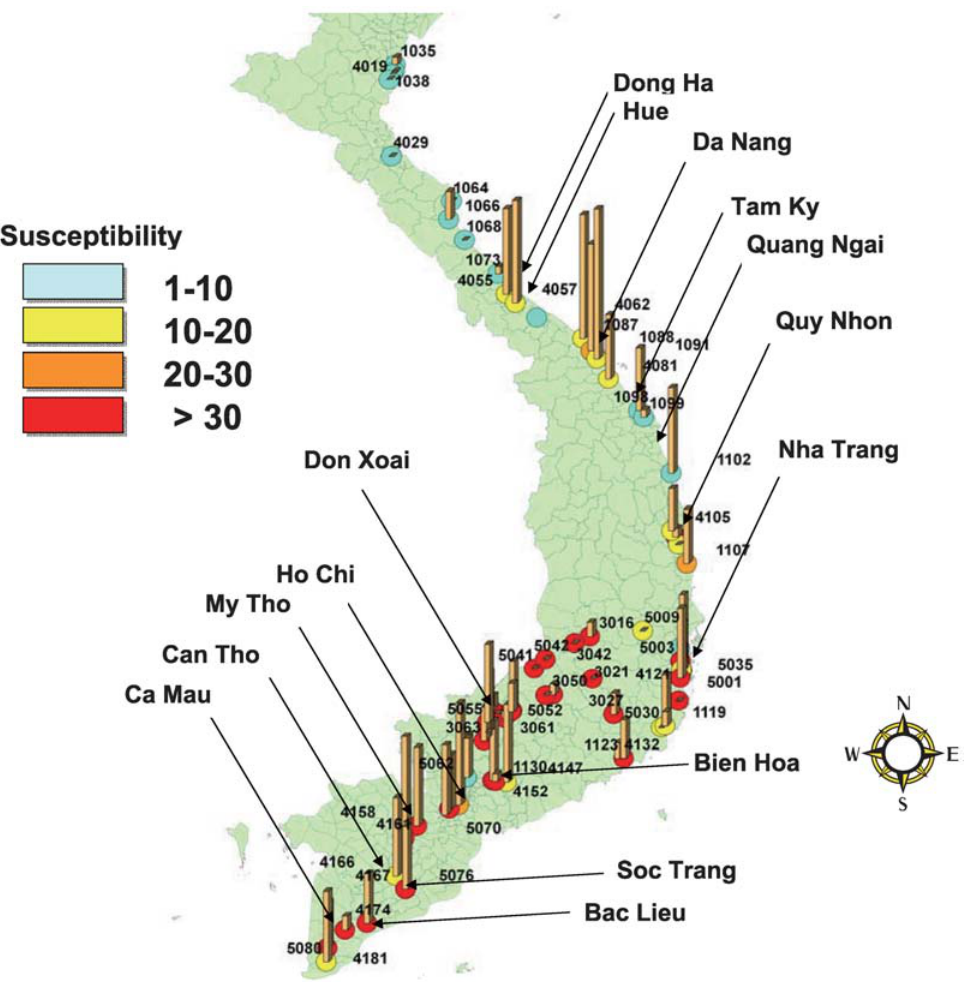
Figure 1. The distribution of the F1269C point mutation in Aedesaegypti collected from used tires in Vietnam. The date and location of the mosquito collection from used tires in Vietnam are indicated. The bars indicate relative frequency of F1269C mutations in the samples collected in one collection site. The color in each circle indicates the susceptibility index, after Kawada et al. [3].